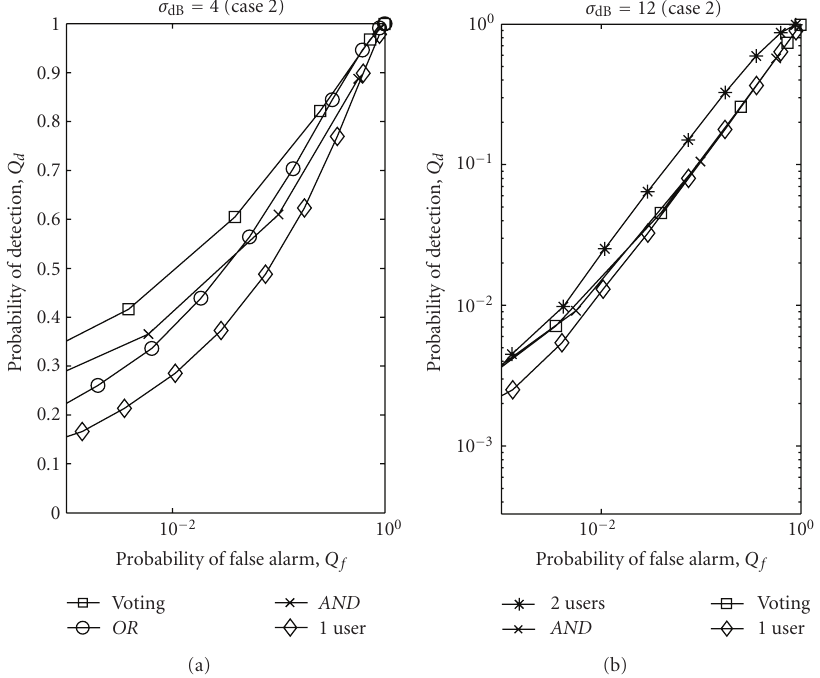
Figure 11: Receiver operating characteristics for 5 collaborating users in spatially correlated shadowing fading (Case 2: half of the users have high